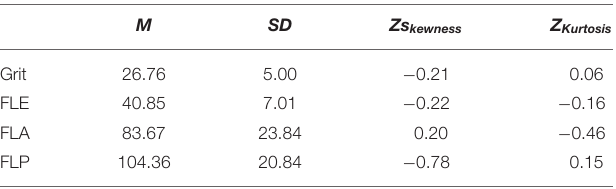
TABLE 3 | The detailed information of grit, FLE, and FLA levels.